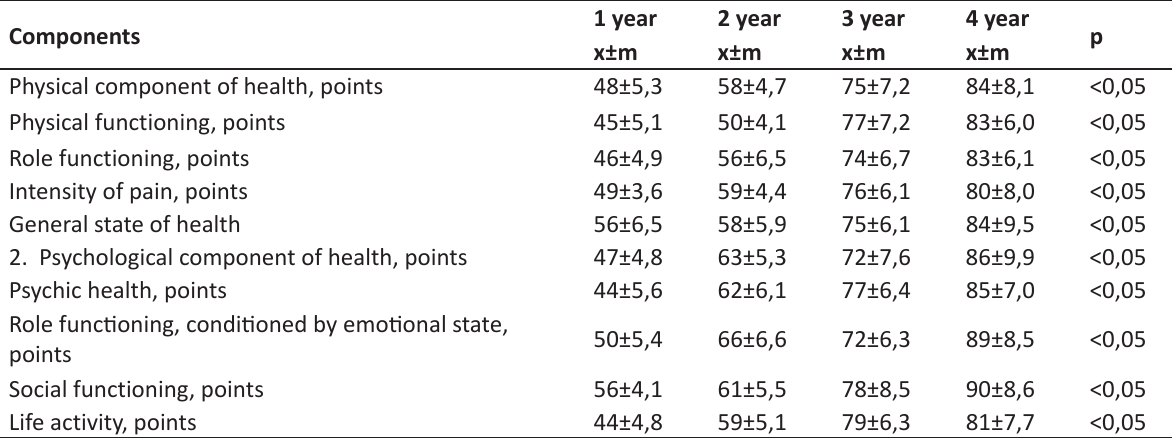
Table 2. Change of students’ life